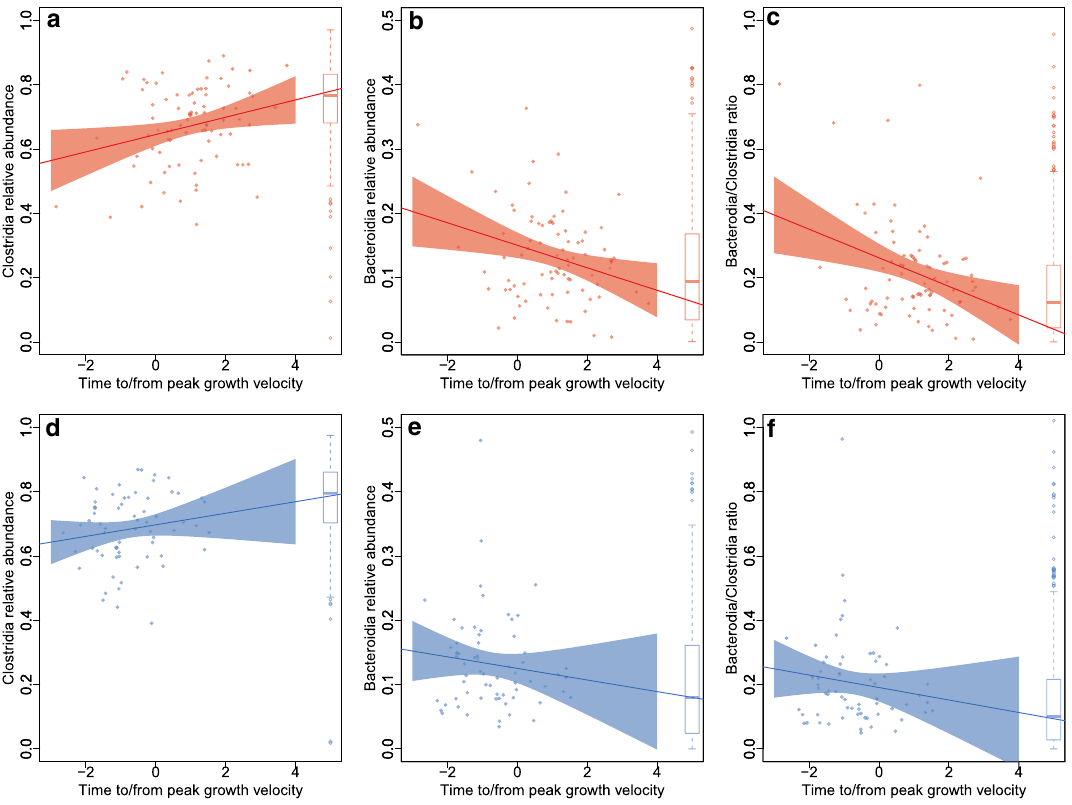
Figure 3. ( a ) Abundance of Clostridiales in relation to pubertal timing (time to/from peak growth velocity) in girls. ( b ) Abundance of Bacteroidales in relation to pubertal timing (time to/from peak growth velocity) in girls. ( c ) Bacteroidales/Clostridiales ratio in relation to pubertal timing (time to/from peak growth velocity) in girls. ( d ) Abundance of Clostridiales in relation to pubertal timing (time to/from peak growth velocity) in boys. ( e ) Abundance of Bacteroidales in relation to pubertal timing (time to/from peak growth velocity) in boys. ( f ) Bacteroidales/Clostridiales ratio in relation to pubertal timing (time to/from peak growth velocity) in